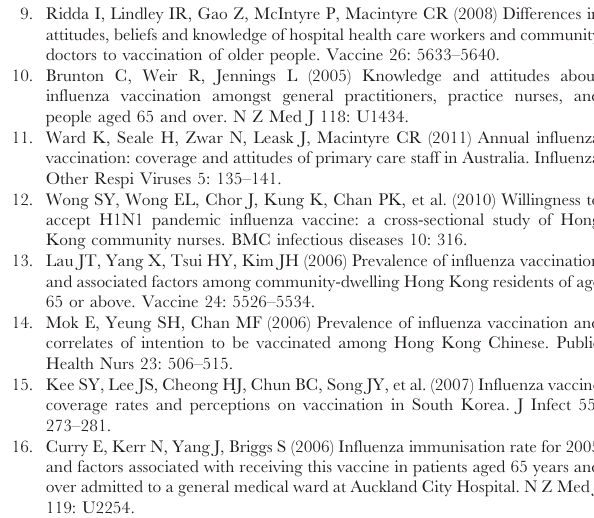
Table S1 Studies reporting on influenza incidence and prevalence. Table S2 Studies reporting on influenza-associated hospitalization. Table S3 Studies reporting on influenza-associated